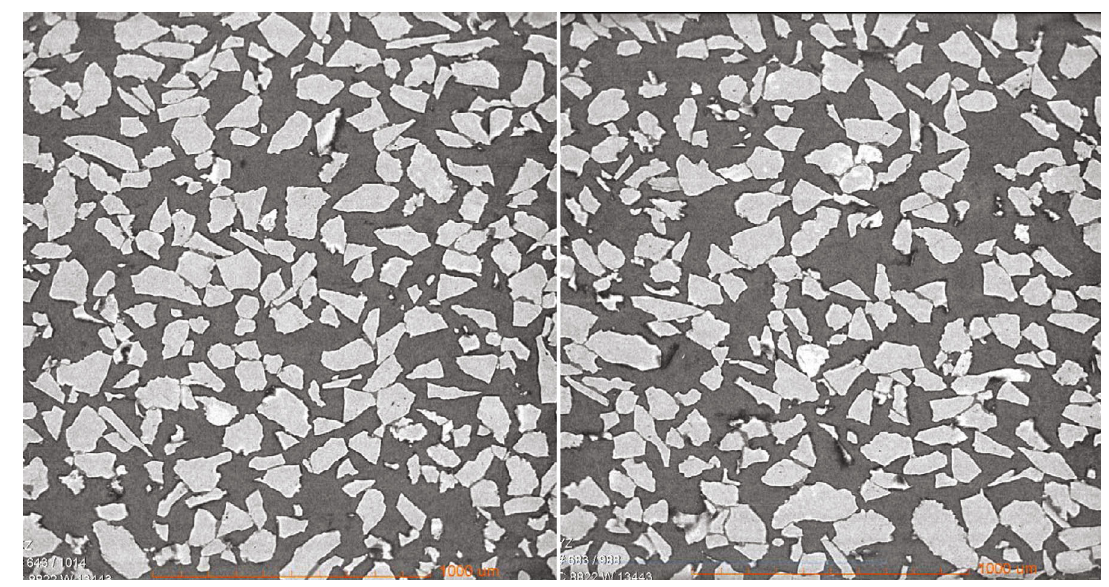
Figure 5: 2D CT image of 3DP